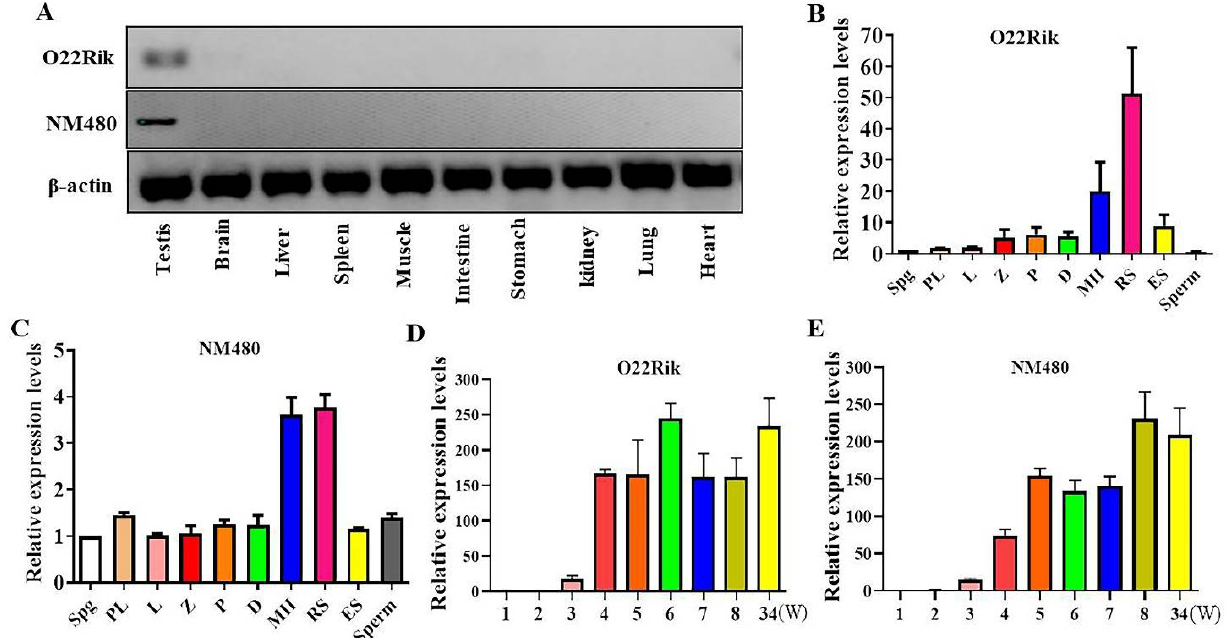
Figure 1. Expression profiles of lncRNA O22Rik and NM480. Total RNA was extracted from each sample using a MiniBEST Universal RNA Extraction kit and transcript expression levels were determined by RT- or qPCR. ( A ) Expression of lncRNA O22Rik and NM480 in various tissues. ( B ) O22Rik and ( C ) NM480 expression levels in the different spermatogenetic cells. Spermatogenic cells were sorted by flow cytometry and their mRNA expression levels were calculated by qPCR assay. ( D ) O22Rik and ( E ) NM480 expression levels in the testis at different stages (1–8, and 34 W (week)) of development. β-actin was used as a loading control to normalize the gene expression levels in different samples. Data were the mean ± SEM ( n = 3). Spg, spermatogonia; PL, preleptotene spermatocytes; L, leptotene spermatocytes; Z, zygotene spermatocytes; P, pachytene spermatocytes; D, diplotene spermatocytes; MII, meiosis II spermatocytes; RS, round spermatids; ES, elongated spermatids; Sperm, spermatozoa.